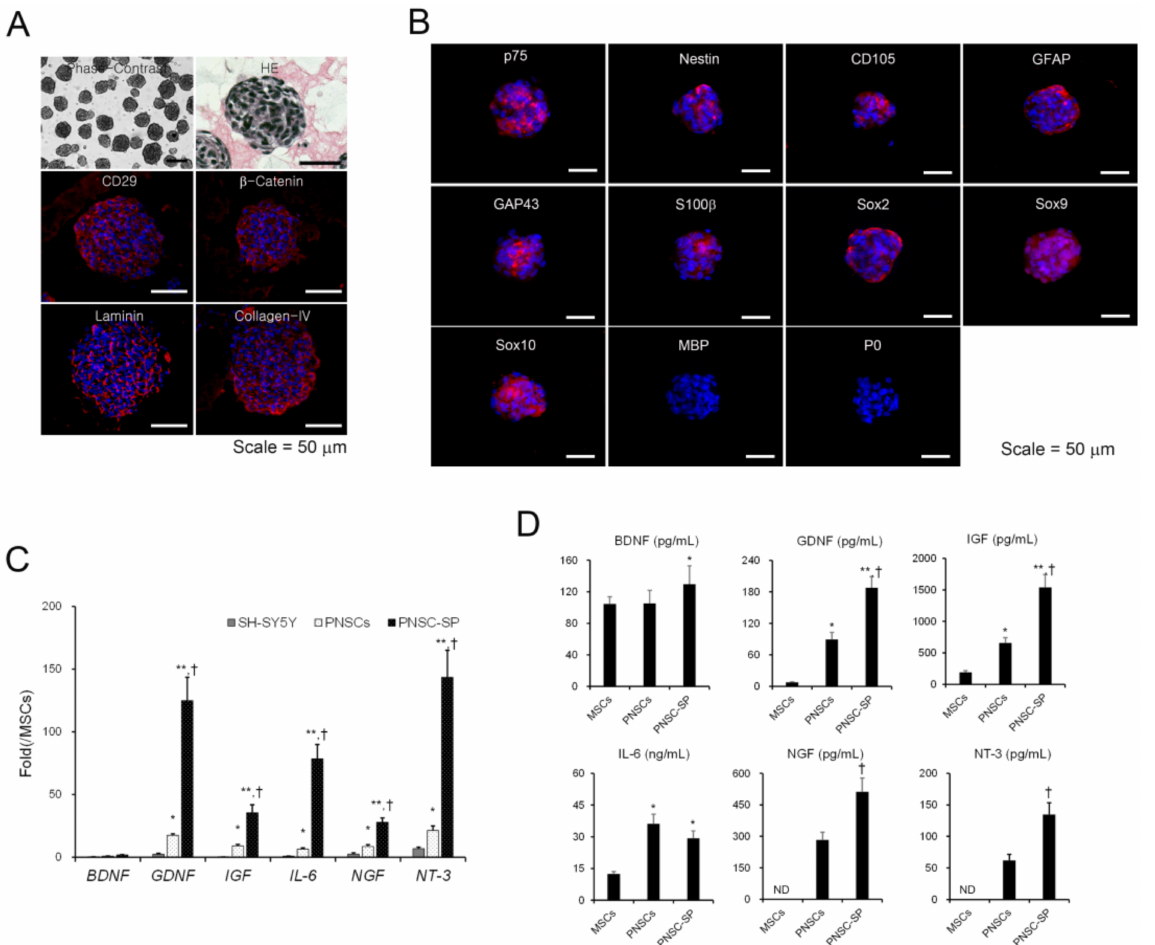
Figure 3. Structural, immunophenotypic, and biomolecular characteristics of peripheral nerve-derived stem cell spheroids (PNSCs). ( A ) Under suspension-culture conditions for three days, PNSCs spontaneously assembled into spheroid structures. ( B ) PNSC spheroids exhibited cell-to-cell and cell-to-matrix interconnections through integrin- β 1 (CD29) and β -catenin, respectively. Notably, the in vitro deposition of synthesized extracellular matrix in spheroids was observed. ( C , D ) PNSCs and PNSC spheroids highly expressed and secreted neurotrophic factor mRNAs and proteins compared to mesenchymal stem cells (MSCs) derived from bone marrow. *, p < 0.05 compared to MSCs, **, p < 0.01 compared to MSCs, †, p < 0.01 compared to